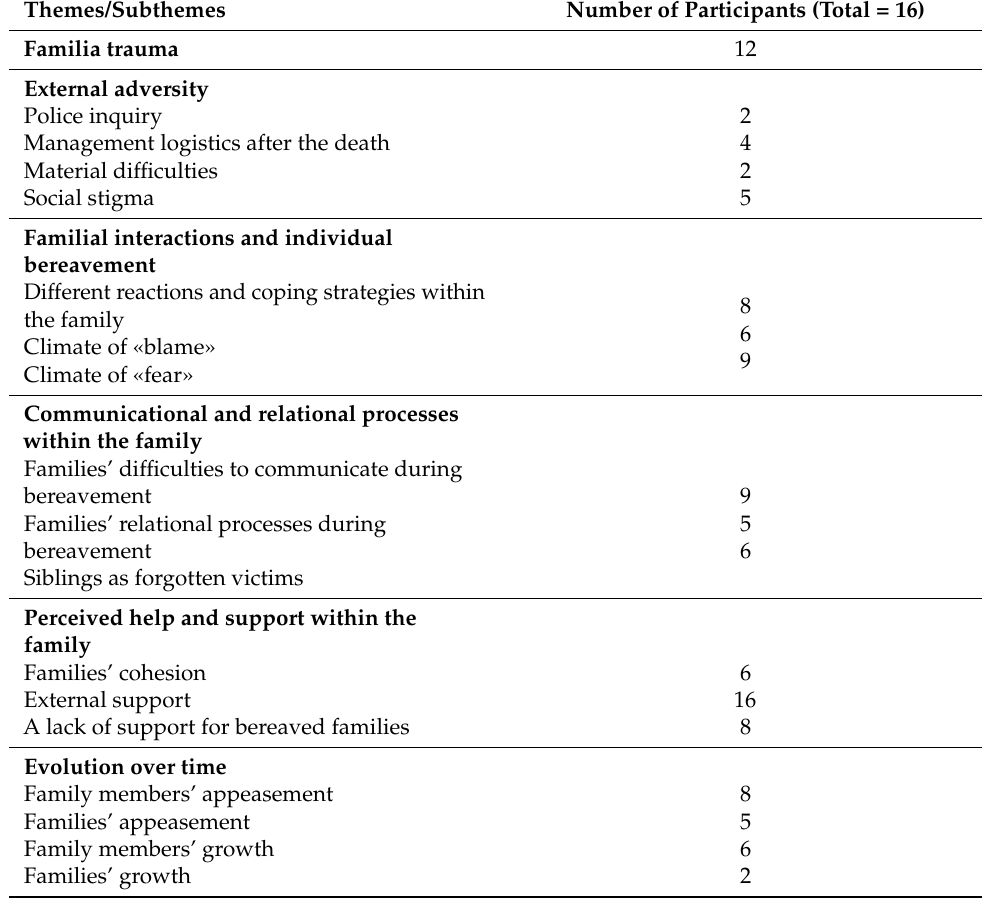
Table 3. Number of participants supporting each